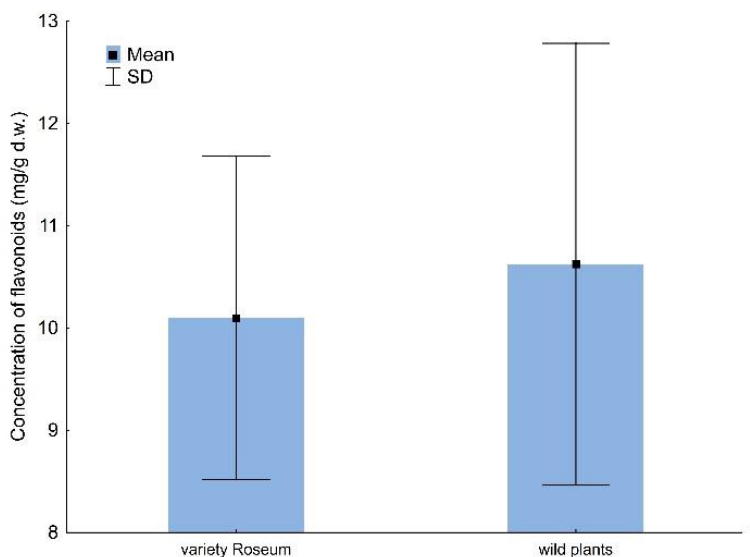
Figure 2. The concentration (mg/g d.w.) of total flavonoids in V. opulus variety Roseum and wild